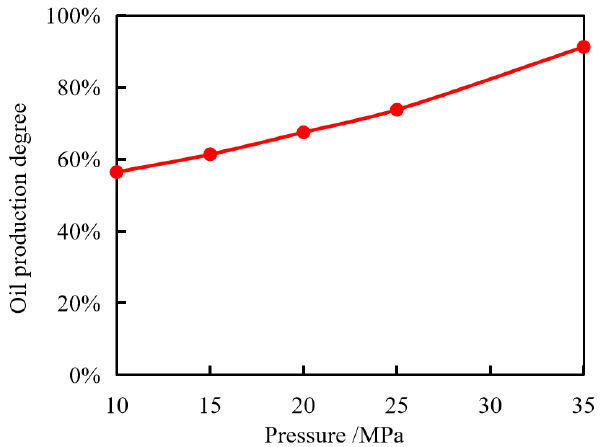
Figure 14. Relationship between crude oil recovery degree and pressure .